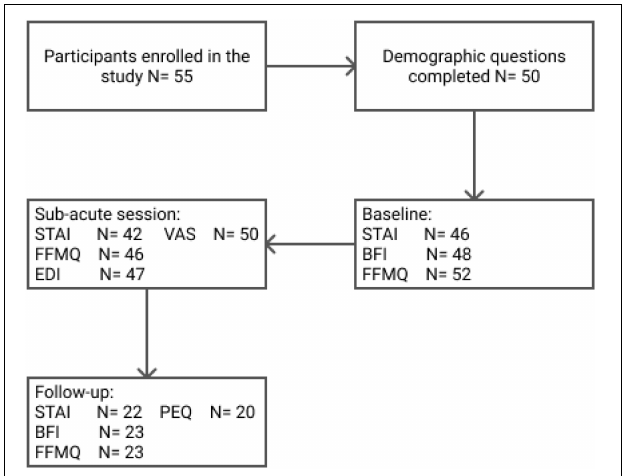
FIGURE 1 | Flow-chart of participants’ enrollment and survey completion.